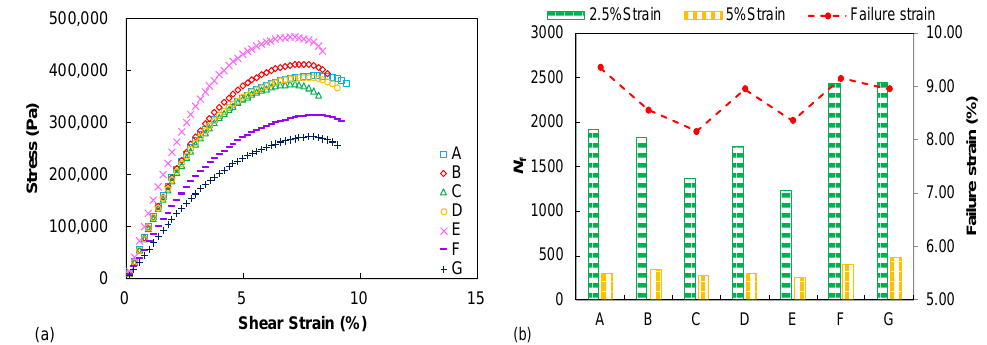
Figure 6. LAS test results: ( a ) stress–strain curves; ( b ) failure strain comparison and strain-controlled fatigue life prediction.